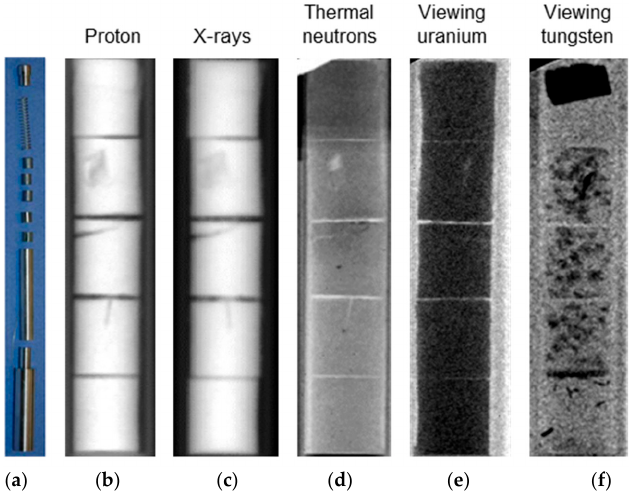
Figure 9. Photograph of five 5 mm long, 4.6 mm diameter dUO 2 mock-up fuel pellets in steel cladding ( a ), as well as 800 MeV proton radiography ( b ) [54], 450 keV X-ray radiography ( c ) [54], thermal neutron radiography ( d ), as well as radiographs at neutron absorption resonance energies of 238 U ( e ) and tungsten ( f ) [44]. The sample orientation is not identical for each modality.